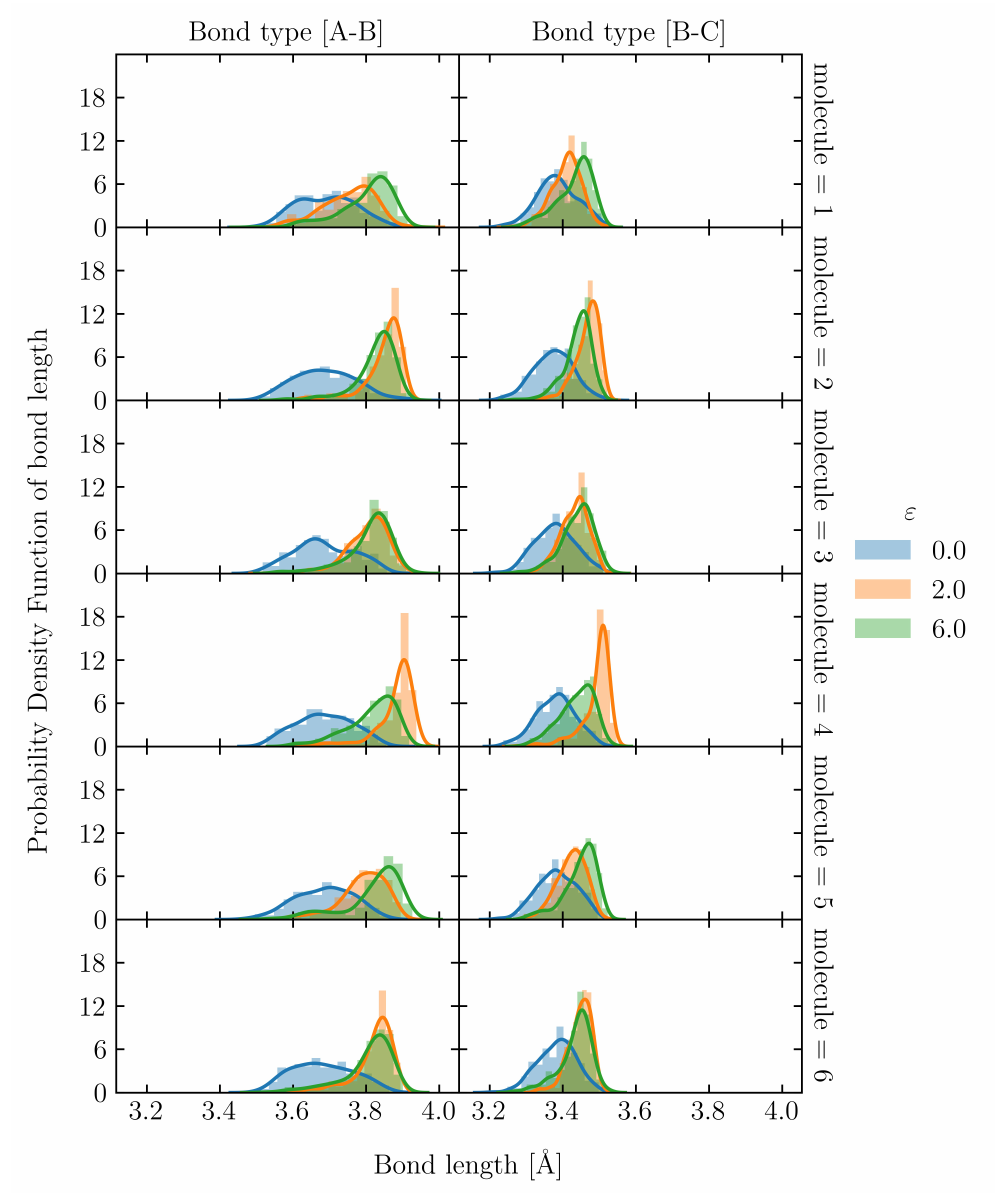
Figure 11. Bond length distribution of S8 at ε = 0.0, 2.0 and 6.0 in 6 representatives out of 32 molecular chains. The solid lines are kernel density estimation over the